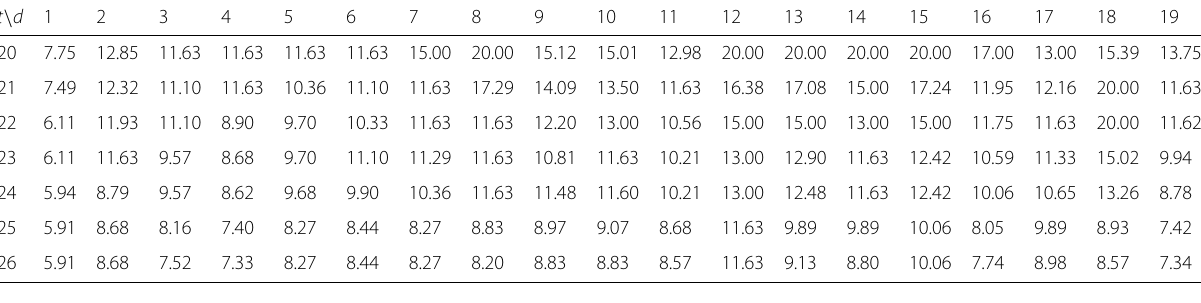
Table 5 Intra-day market unit prices